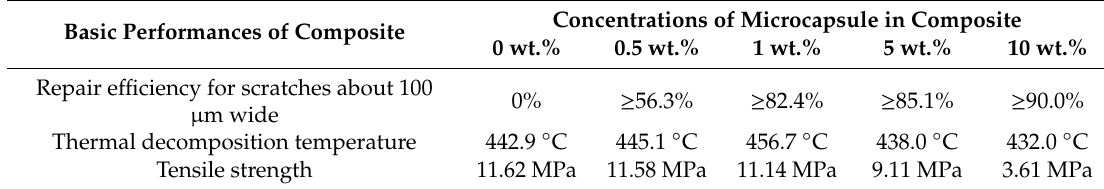
Table 1. Basic performance of the composite with di ff erent concentrations of microcapsule. Basic Performances of